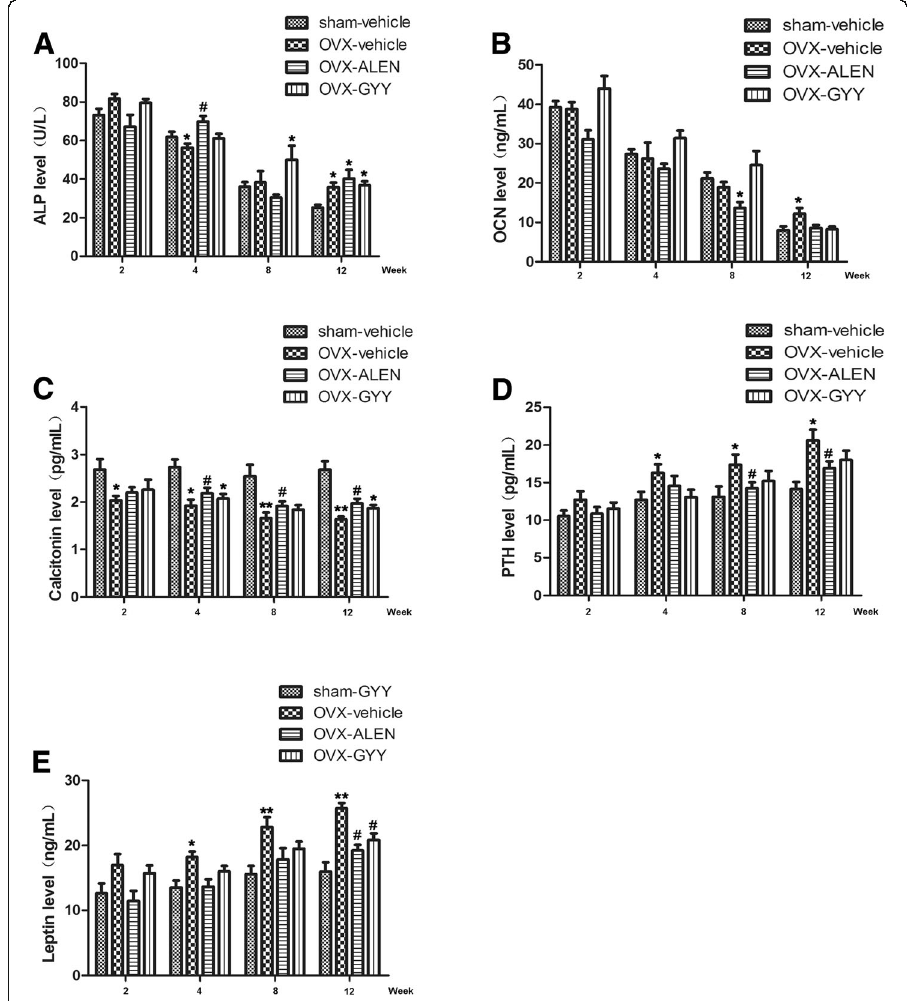
Fig. 2 The effect of GYY4137 on the hormone levels in the rat plasma related to bone metabolism in the OVX model. The levels of a alkaline phosphatase, b osteocalcin, c calcitonin, d parathyrin and e leptin were assessed in all four groups of rats. * p <0.05 vs. sham-vehicle group; ** p <0.01 vs. sham-vehicle group; # p <0.05 vs. OVX- vehicle group; ## p <0.01 vs. OVX-vehicle. OVX-vehicle: ovarectomized rats treated with vehicle; OVX-ALEN: ovarectomized rats treated with alendronate sodium; OVX-GYY: ovarectomized rats treated with GYY4137